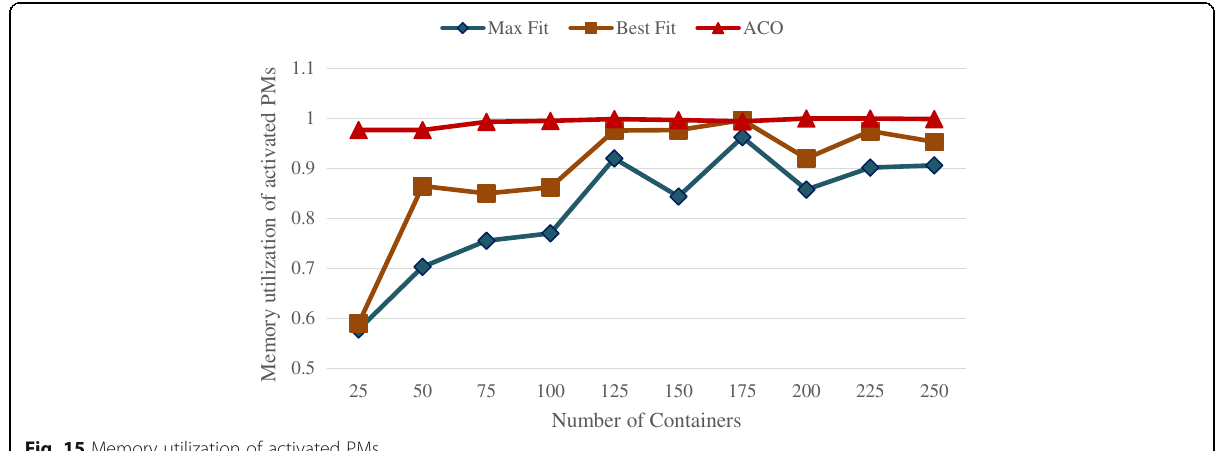
Fig. 15 Memory utilization of activated PMs